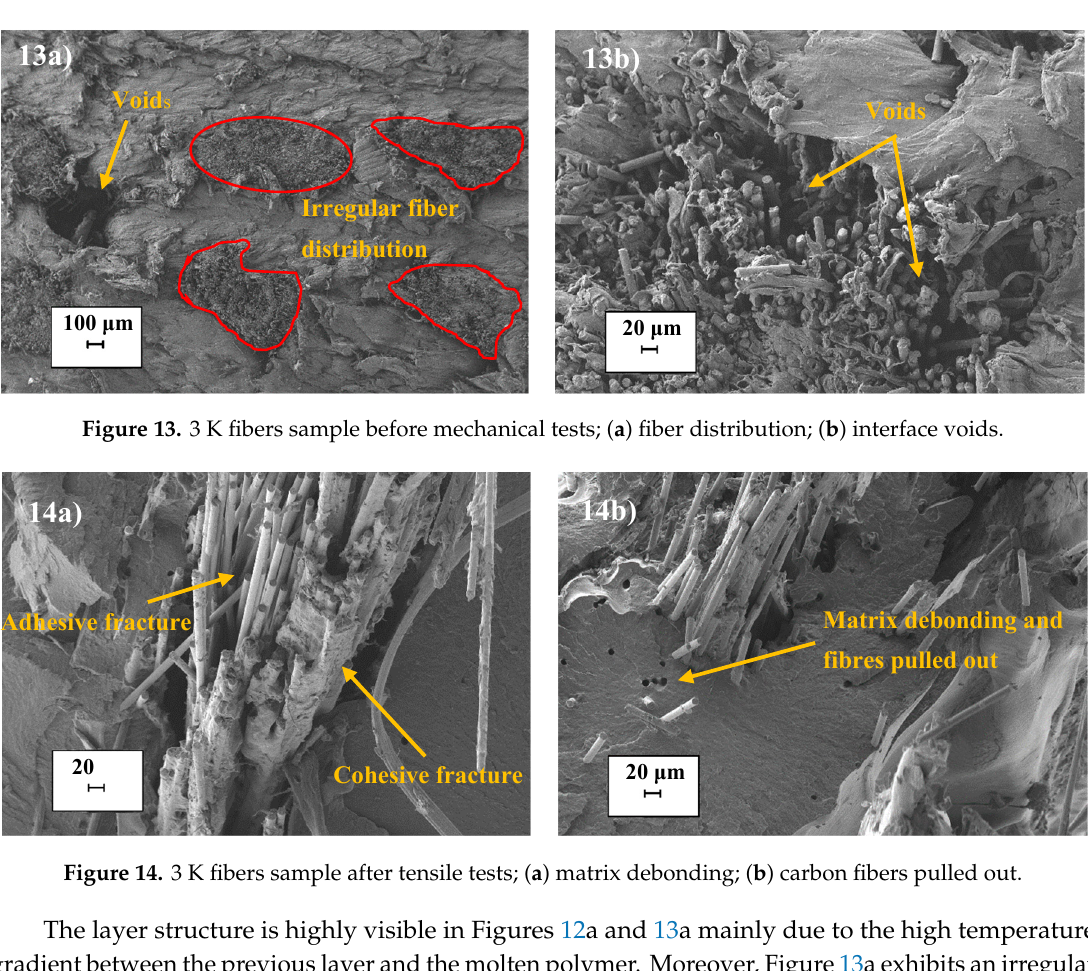
Figure 12. 1 K fibers sample before mechanical tests; ( a ) layer structure; ( b ) matrix/fibre interface.